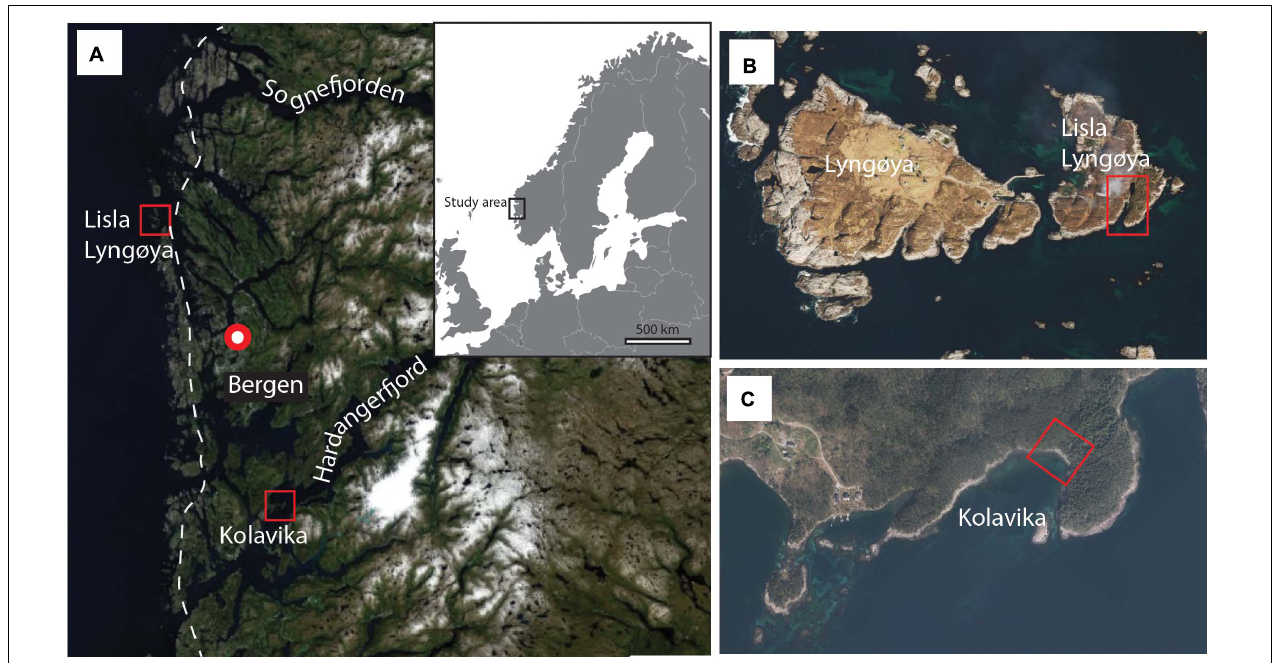
FIGURE 1 | (A) Location of the two study sites in the NW part of the North Sea basin. (B) Lisle Lyngøyna aerial photo from (Norway in pictures). (C) Kolavika (aerial photo from Norway in pictures).